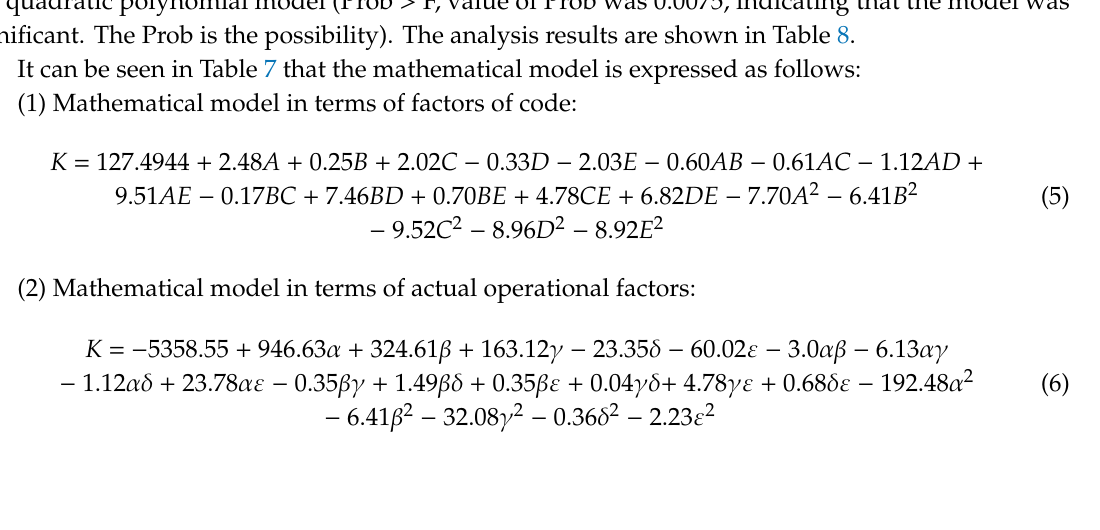
Table 7. Basic operation parameters in the separation experiments.